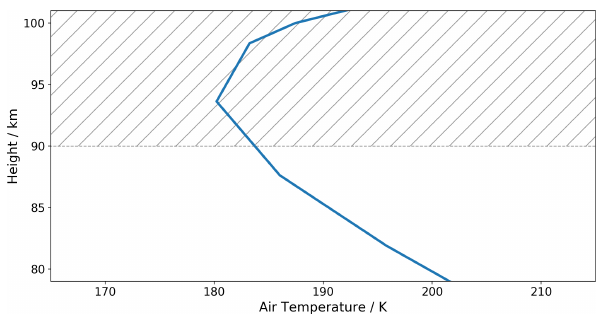
Figure 2. Nudging temperature profile over the region of interest sampled on model levels (80–100km). Shading indicates the height above which this nudging profile is used in the ExUM model run.